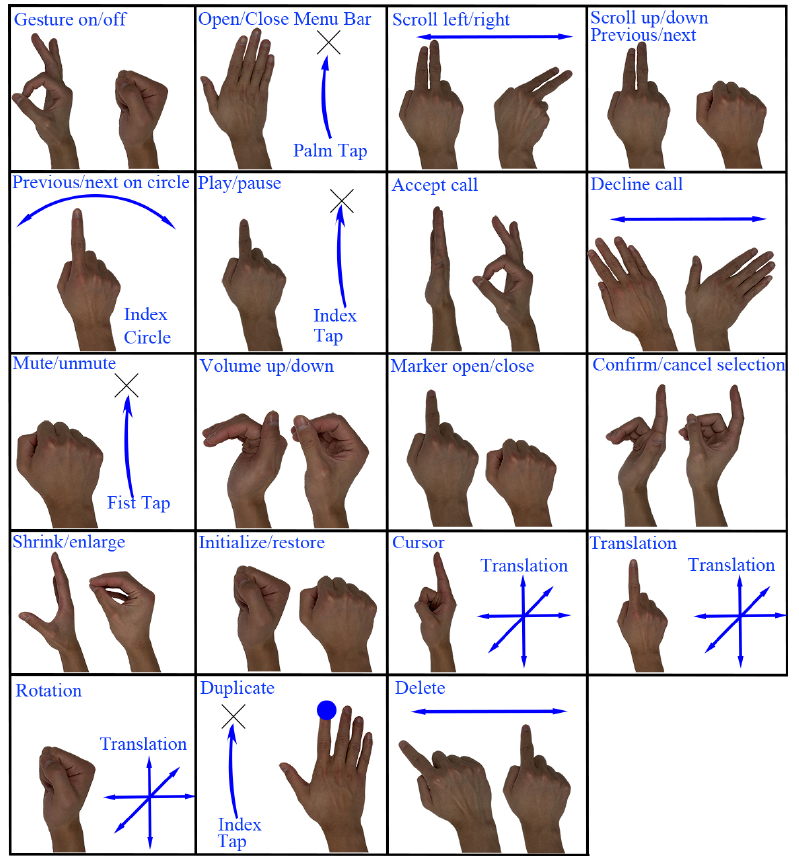
Figure 5. The assignment of microgestures to 20